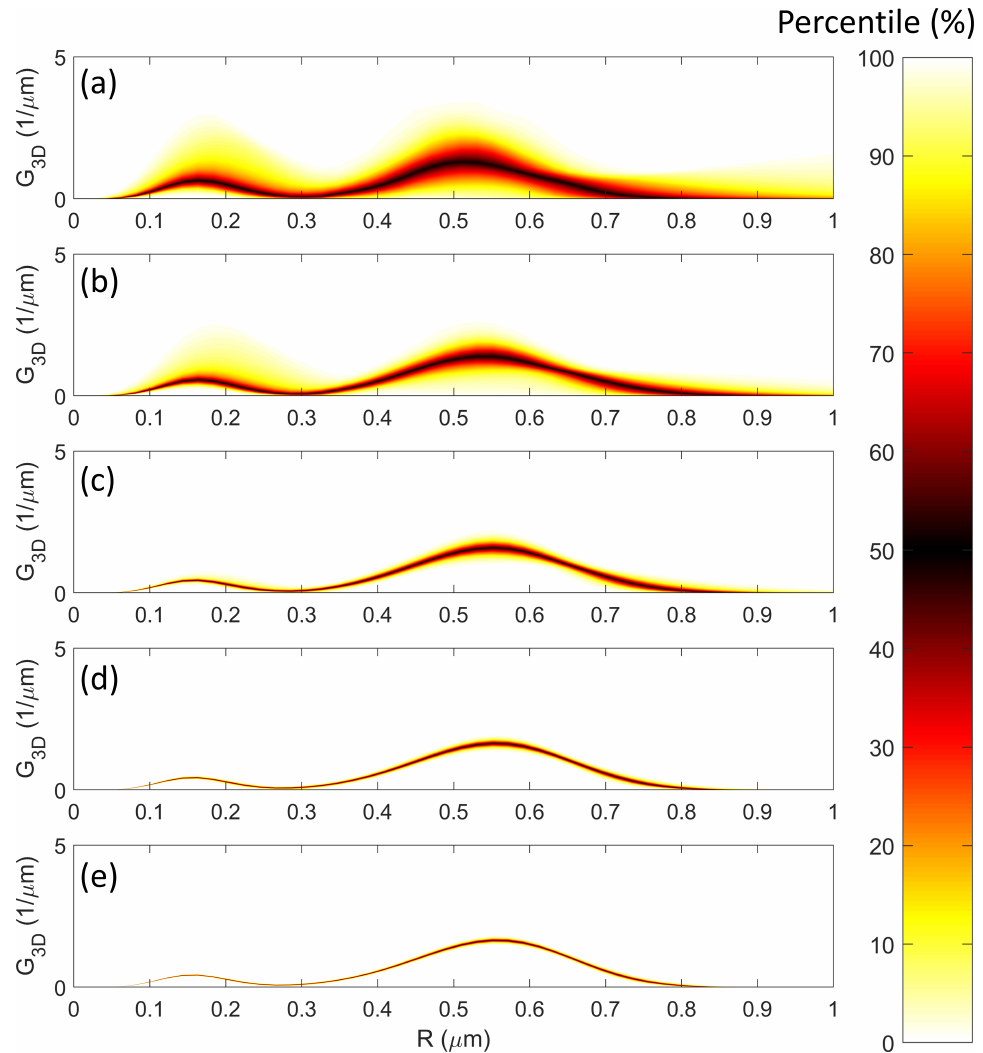
Figure 11. The error and Uncertainty in the approximated 3D size distribution as a function of sample size, where ( a ) has a sample size of 300, ( b ) has 1000, ( c ), has 3000, ( d ) has 10,000, and ( e ) has a sample size of